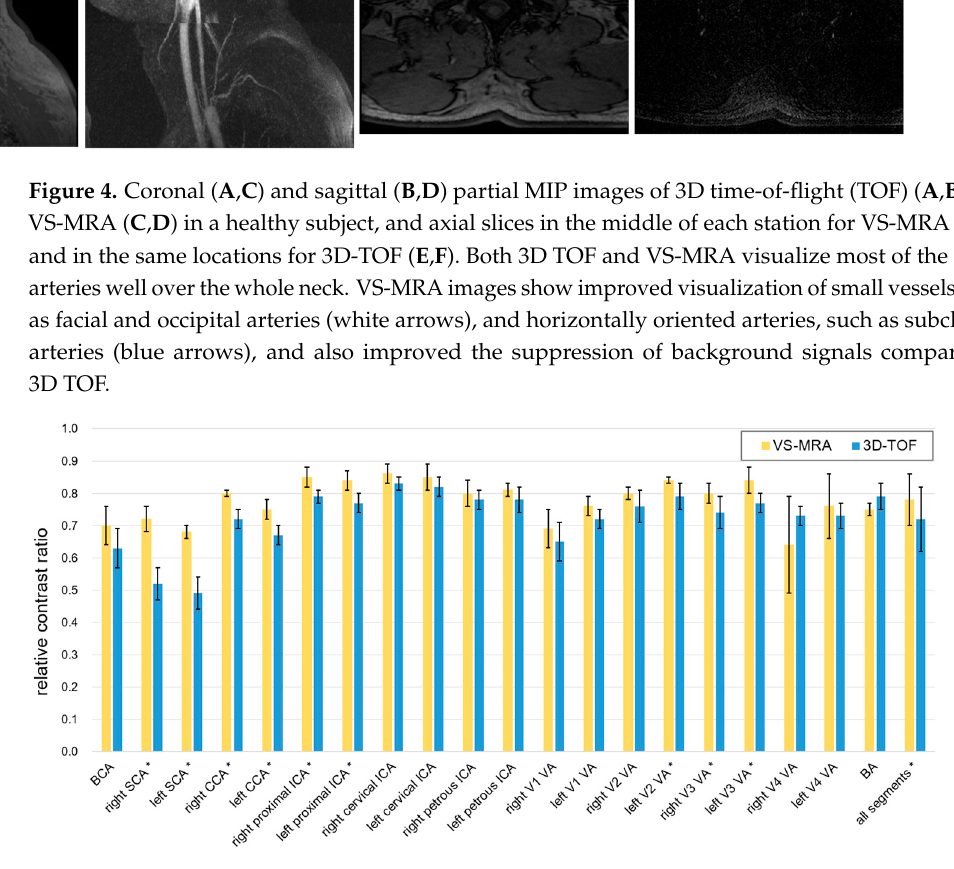
Figure 5. Relative contrast ratio (CR) between artery and muscle signals. Collectively over all 20 arterial segments, the relative CRs were 0.78 ± 0.08 and 0.72 ± 0.10 for VS-MRA and 3D TOF, respectively. The average CR was higher in VS-MRA for all segments, except for the V4 segment of the right vertebral artery and basilar artery. The segments with statistical significance were indicated with asterisks ( p < 0.05). (Abbreviations: BCA = brachiocephalic artery; SCA = subclavian artery; CCA = common carotid artery; ICA = internal carotid artery; VA = vertebral artery; BA = basilar artery).